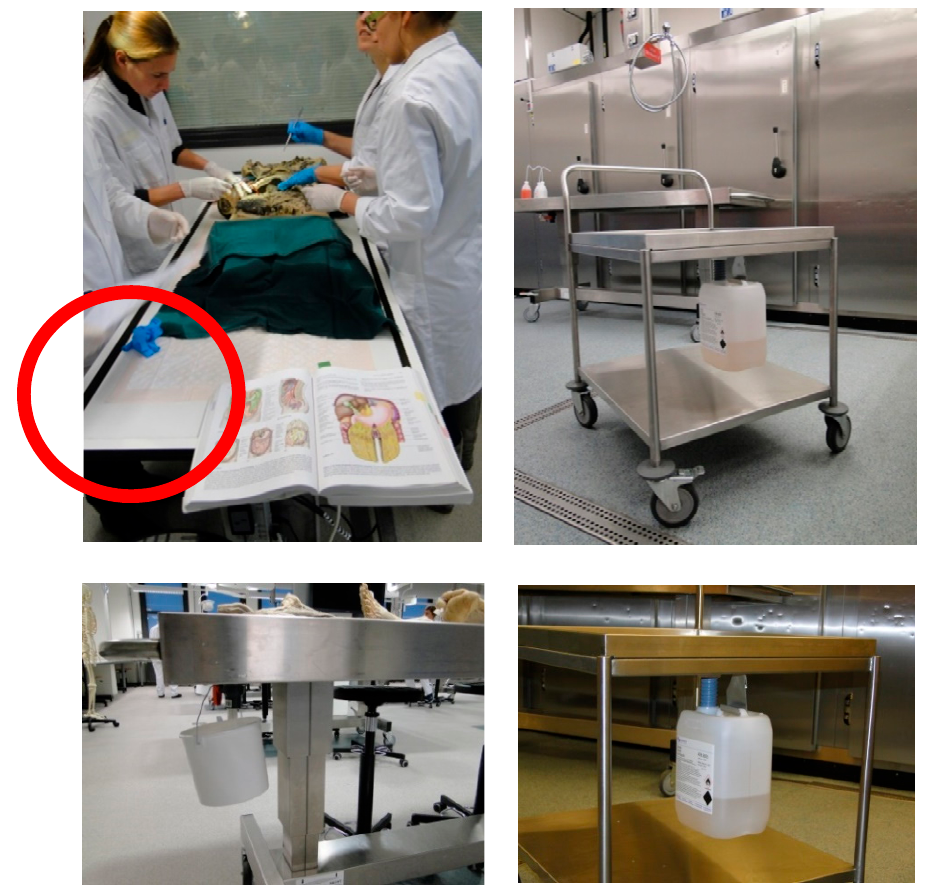
Figure 4. Before ( left panels ) and after ( right panels ) elimination of disposable absorbent sheets (red circle) and introduction of a containment system (instead of an open bucket) to collect leaking formalin residue (T-2 in Table 2).